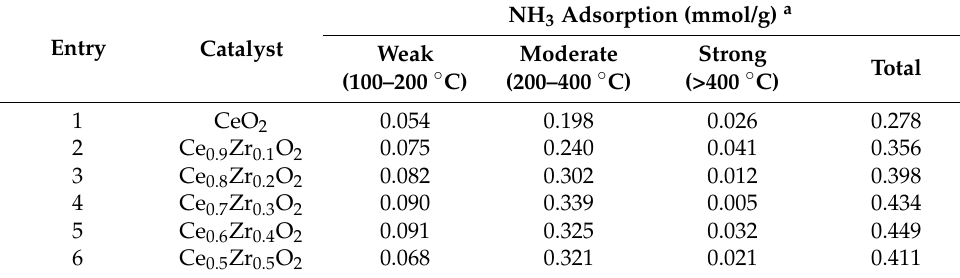
Table 2. Acidic amounts of the catalysts calculated from NH 3 -TPD measurement.